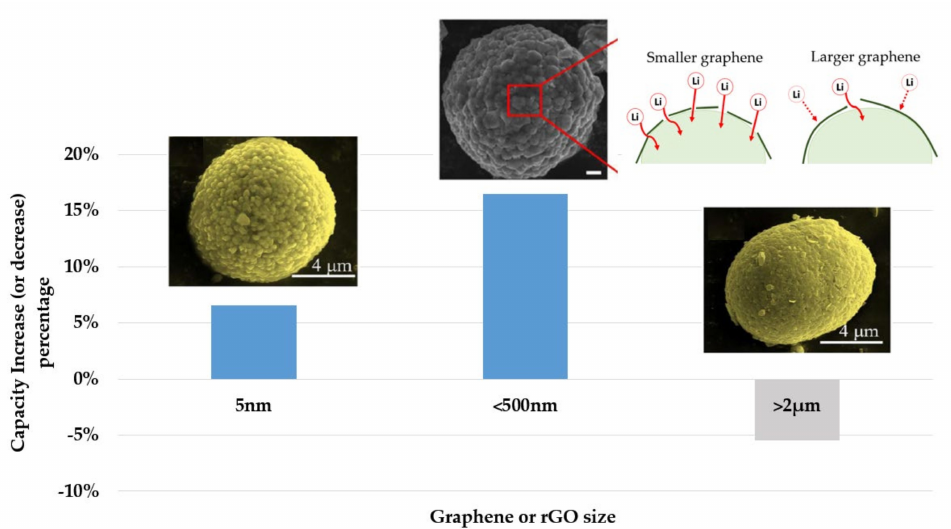
Figure 12. Comparison of specific capacity changes with the graphene (or rGO) coating with different flake sizes on NCA particles. The graphene (or rGO) contents of all samples are 0.5 wt.%. SEM micrographs on the left and right are from ref. [136] and the one in the center is from ref. [135], where the scale bar indicates 1 µ m. Schematic drawing illustrates the concept of Li + ion diffusion pathways related to the flake sizes of graphene coating. Reproduced with permission from ref.